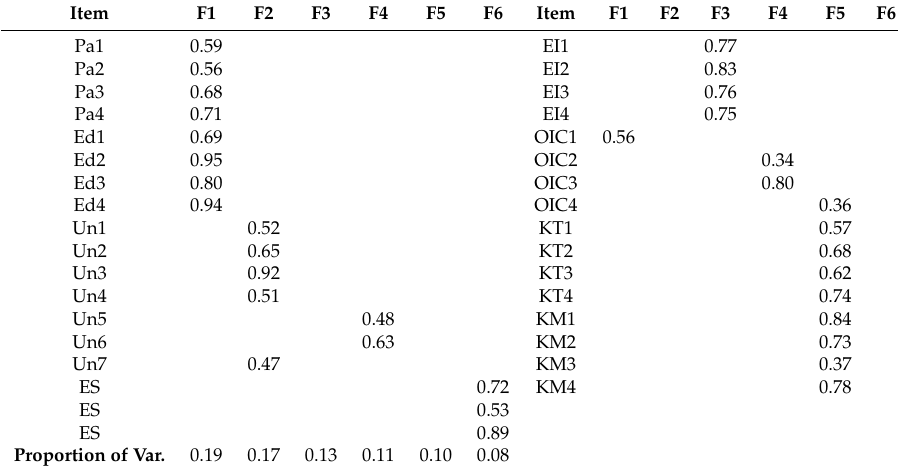
Table 1. Exploratory factor analysis. The highest latent abstract factor standardized weight is presented for each observed questionnaire item. At the bottom, the proportion of item variance is expressed for each factor. Seventy-seven percent of all the variance between items is explained by six latent abstract factors. Participants or interns (Pa), educators or tutors (Ed), university (Un),